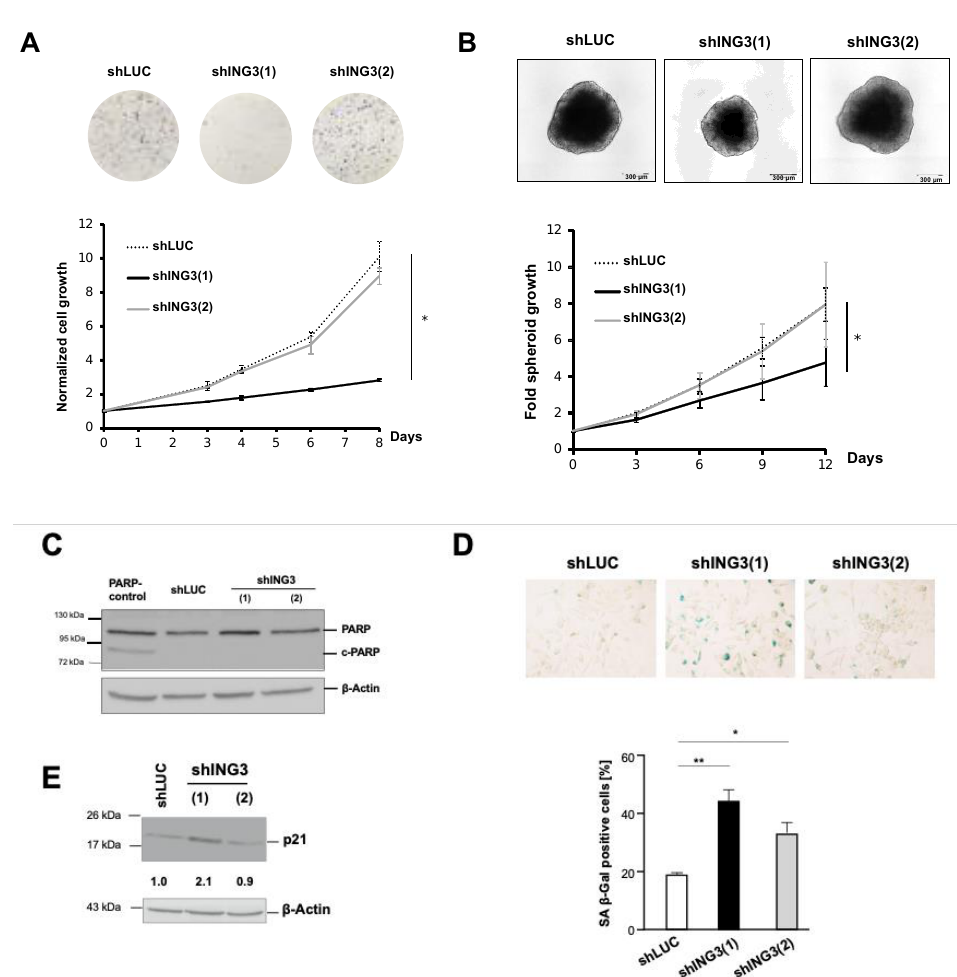
( B ) and protein ( C ) levels and compared with empty control vector shLUC, which was set arbitrarily as one. Results represent the mean of triplets, and error bars show standard deviation of the mean. p value < 0.0001 (****); ns: not significant.